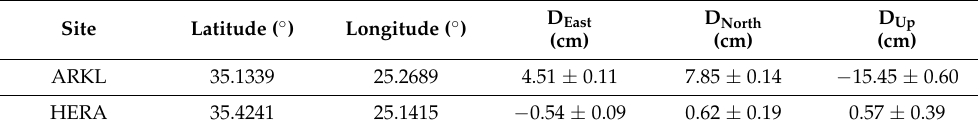
Table 4. GNSS stations’ coordinates and the respective vector of the co-seismic